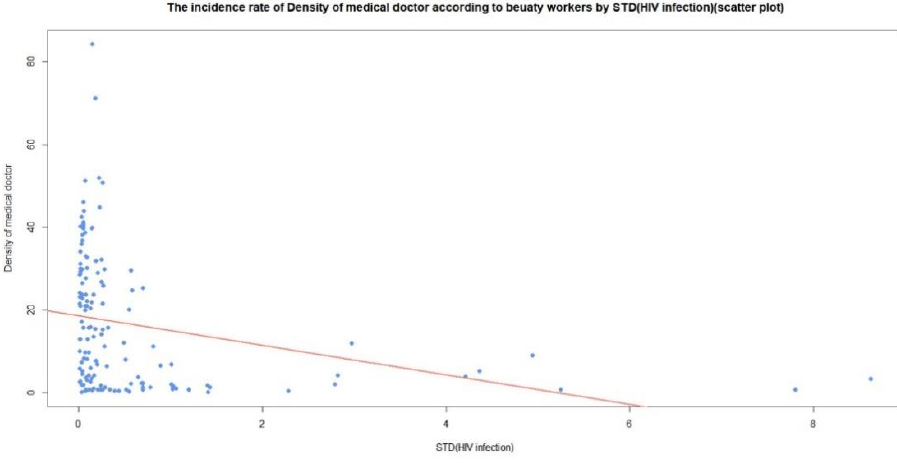
Table 16. Regression between STDs (HIV infection) and